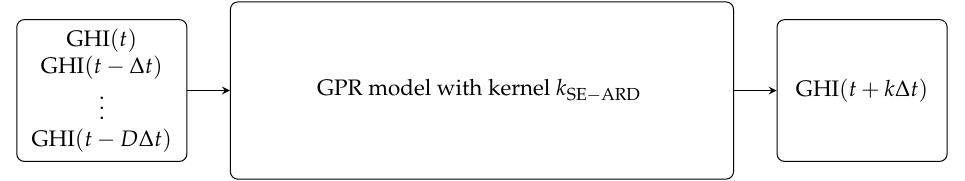
Figure 6. Observation-based horizon-specific GPR model with kernel k SE